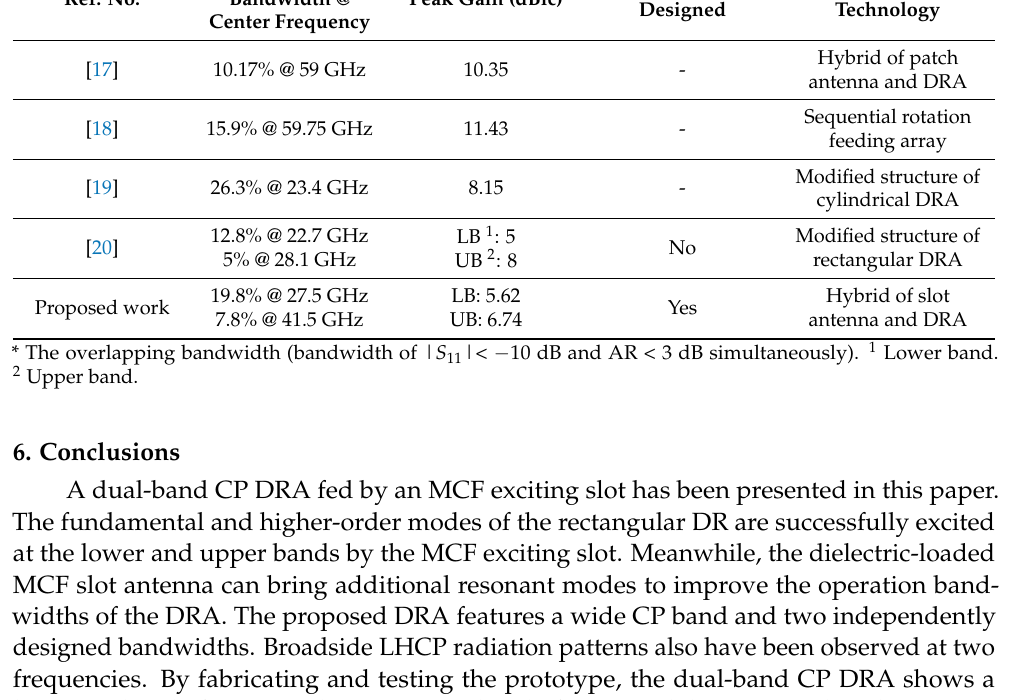
Figure 12. Simulated and measured gains of the proposed DRA. Table 2. Performance comparison of the proposed DRA with previously reported mm-wave DRAs. Ref.